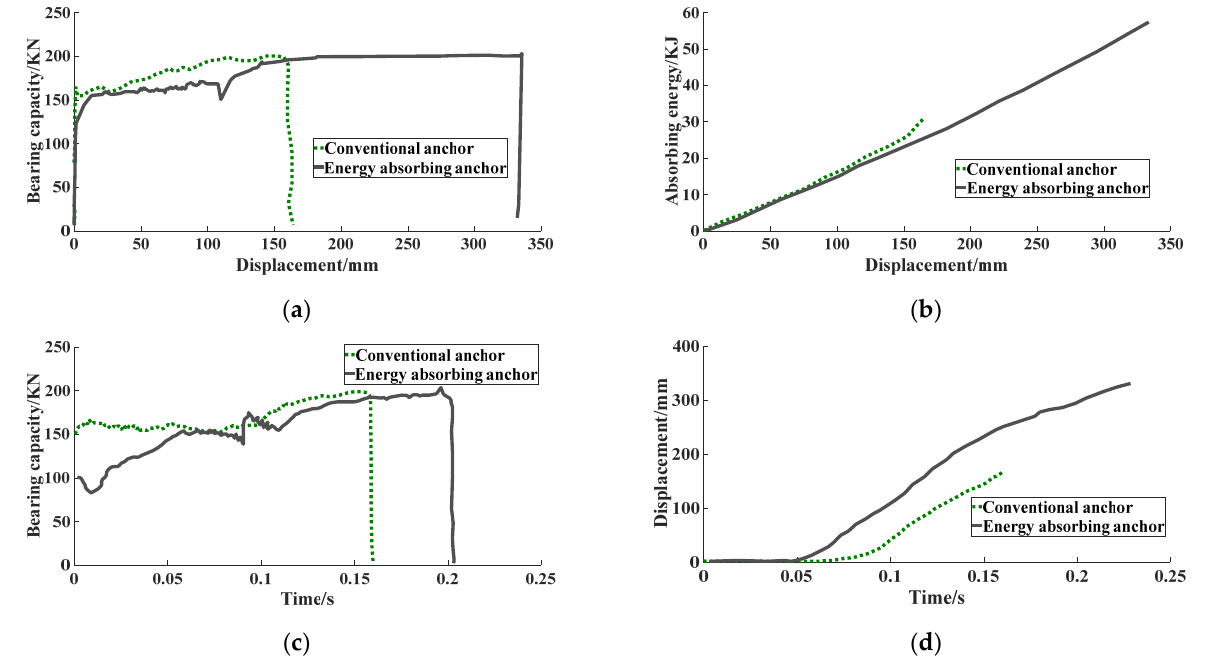
Figure 12. The comparison of the mechanical property curves of conventional anchor and energy absorbing anchor: ( a ) bearing capacity-displacement curve; ( b ) energy absorption characteristic curve; ( c ) bearing capacity-time curve; ( d ) displacement-time curve. Table 6. Comparison of mechanical properties of conventional anchor and energy absorbing anchor.